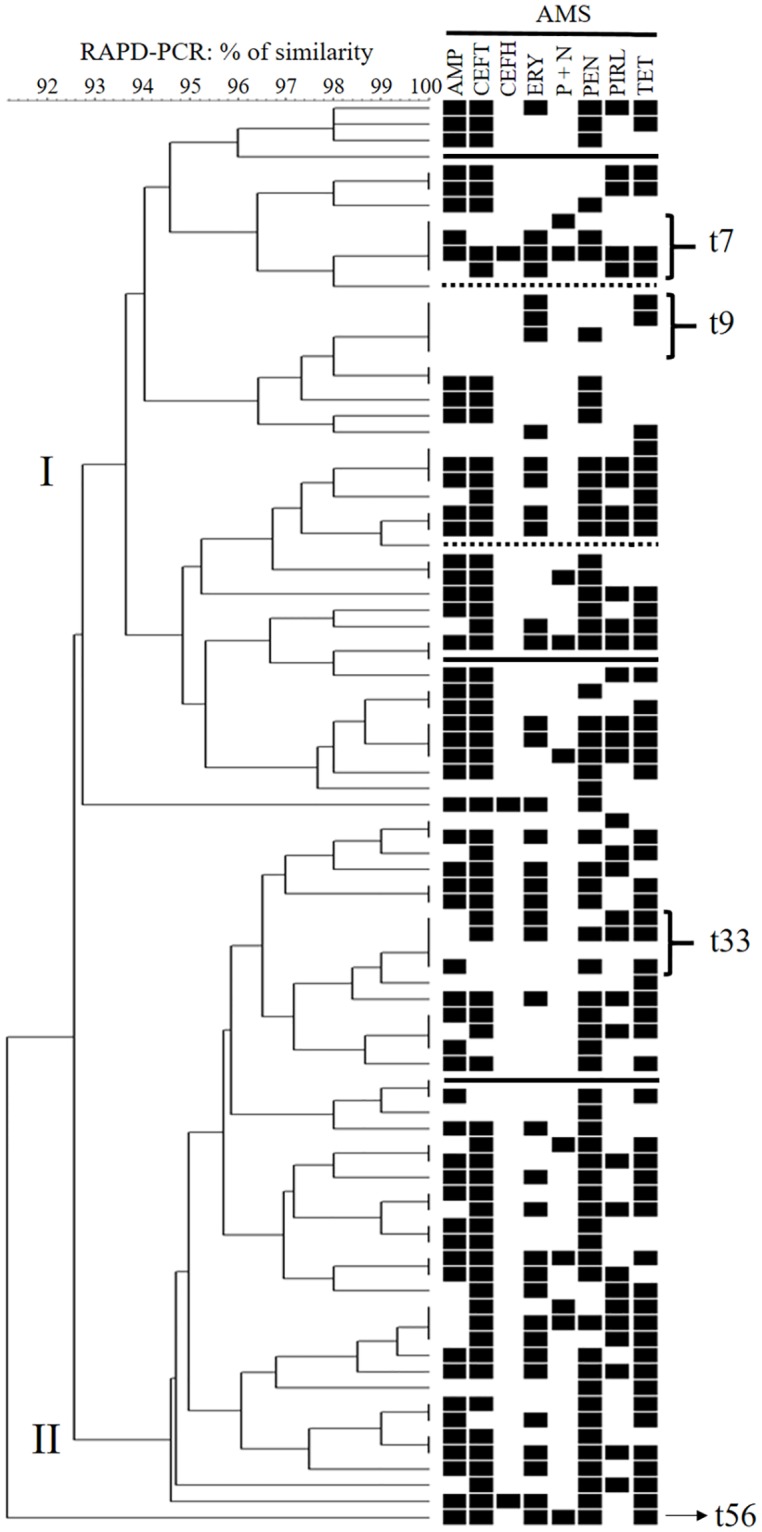
Dendrogram of RAPD profiles of Strep. uberis strains (n = 88) recovered from cows with clinical mastitis and results of susceptibility to 8 antimicrobials (n = 83).Three isolates were contaminated (solid line) and two had no growth during re-inoculation for AMS testing (dotted line). The interpretive criteria to categorize the RAPD-types as resistant (black boxes) or susceptible (without boxes) were based on CLSI guidelines [33].